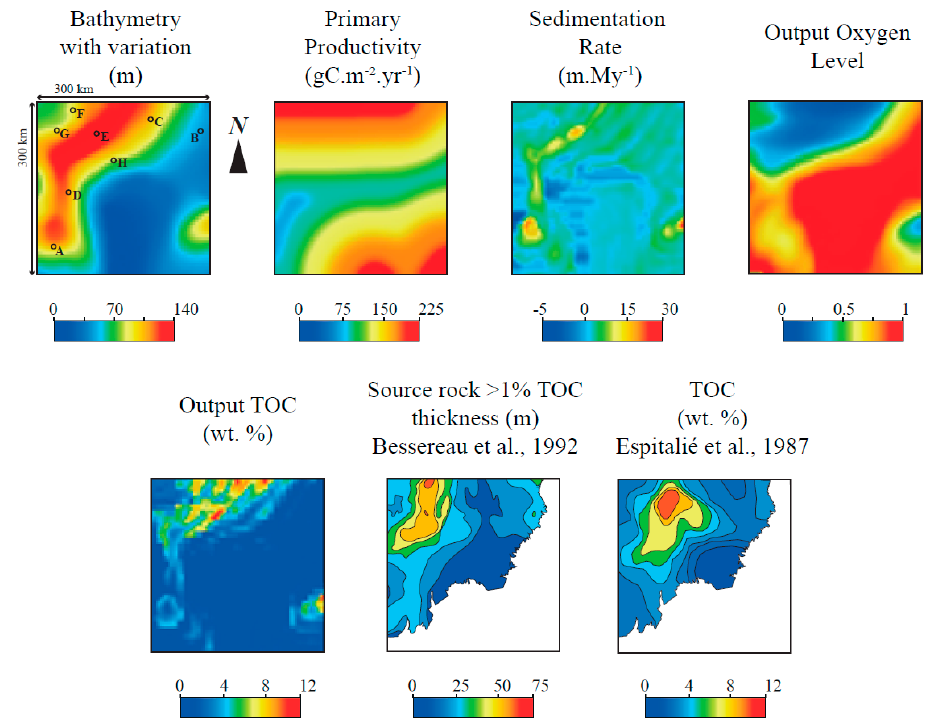
Figure 14. Examples of best-fit meta-model that matches well data for the interval 3 (181.7 to 181.5 Ma). In this example, critical parameters are: Variation on initial bathymetry = − 10 m; PP0 = 225 gC·m − 2 ·year − 1 ; organic matter diffusive transport = 0.45 km 2 ·kyrs − 1 ; Oxygen mixing rate = 0.95. Source rock thickness (>1% TOC) and TOC maps are from Bessereau et al. [31] and Espitalié [54] (the white area are eroded).